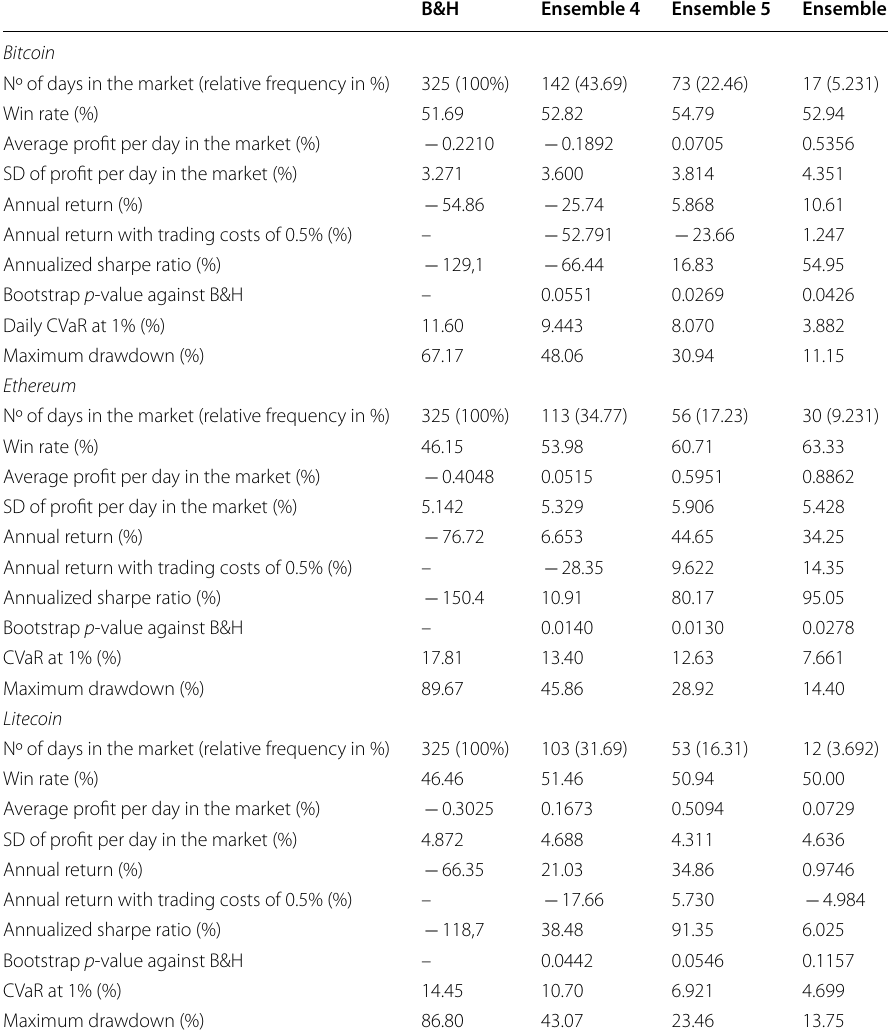
Table 7 Performance of the trading strategies on the test sample, based on model